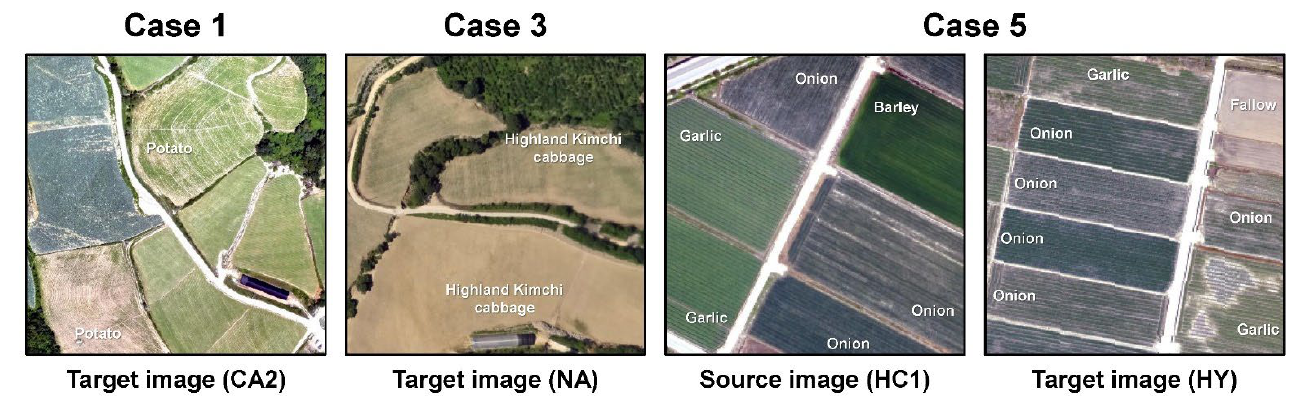
Figure 8. The variations in the proportions of crop parcels in the two study areas for the six different domain adaptation cases.